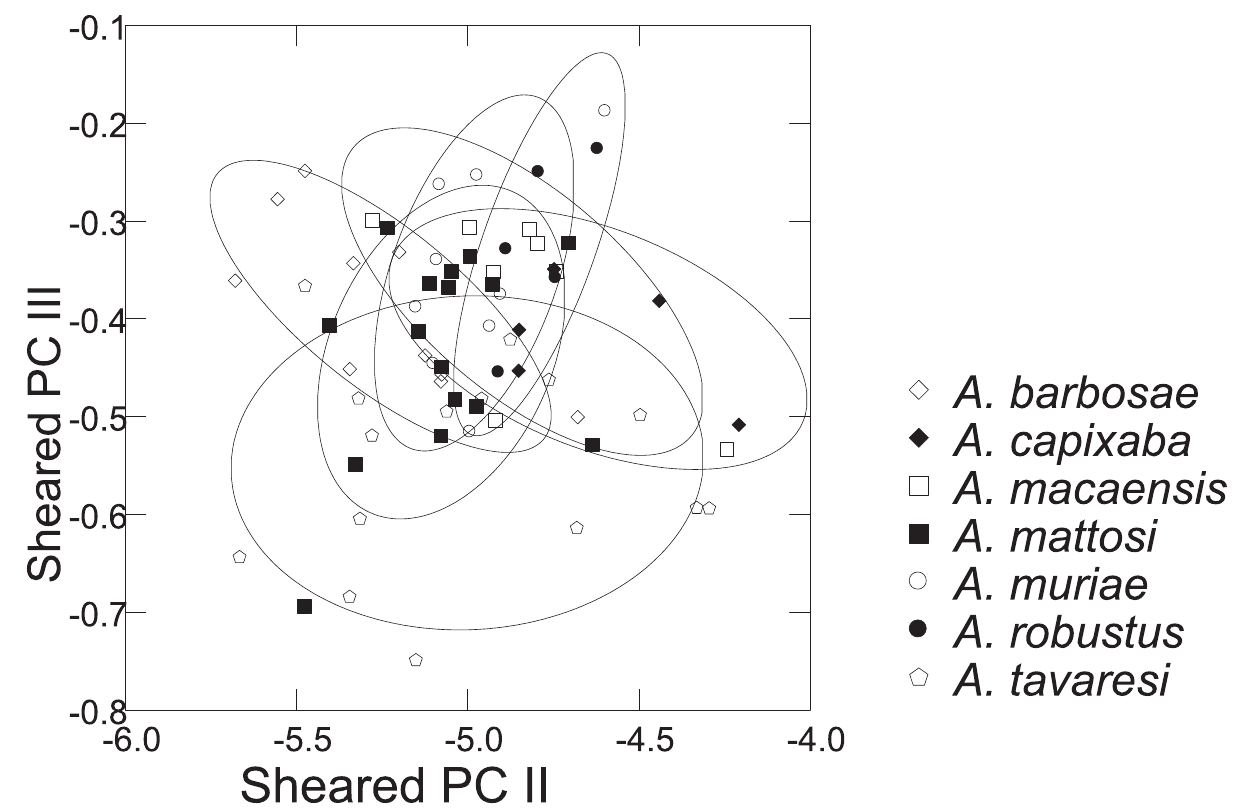
Fig 7. Plot of scores of P C III on PC II from PCA of 15 distance measurements of northern species of Australoheros , assigned to nominal species based on locality and/or species status, represented by minimum five specimens. (Table S4.6 in S4 File).